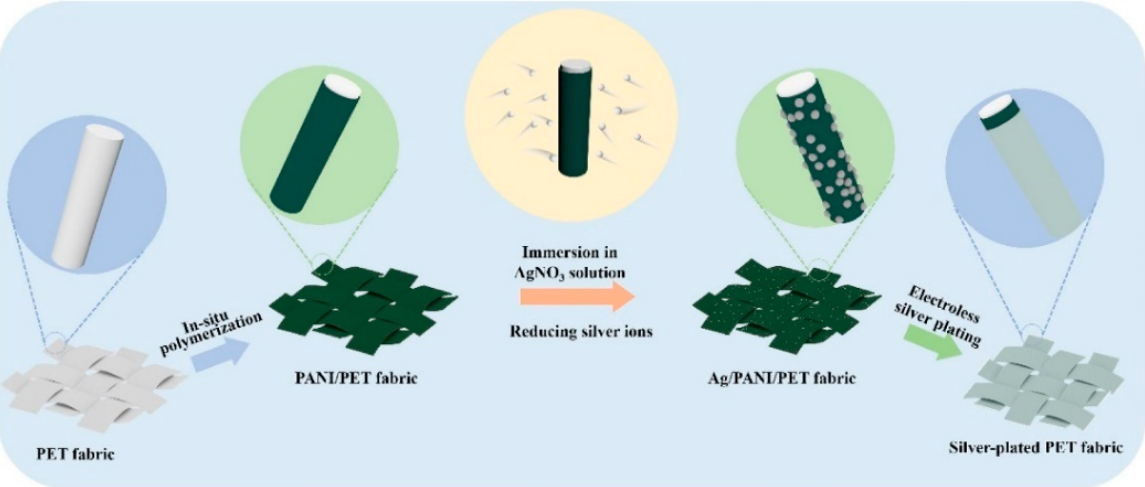
Figure 3. Preparation of silver-PANI sensor. Adapted with permission from Ref. [69]. Copyright© 2019 Elsevier.